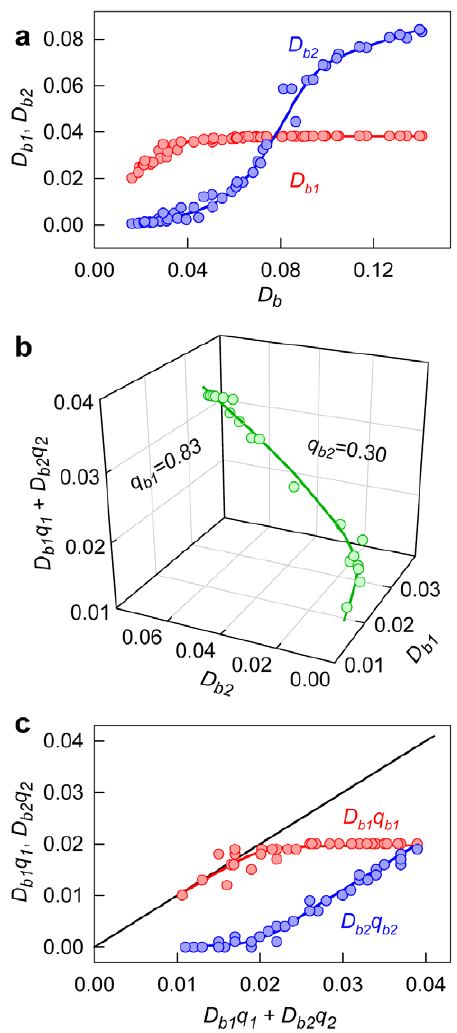
trations after microdialysis. In the case of two binding modes, a relation similar to equation (16) is valid: